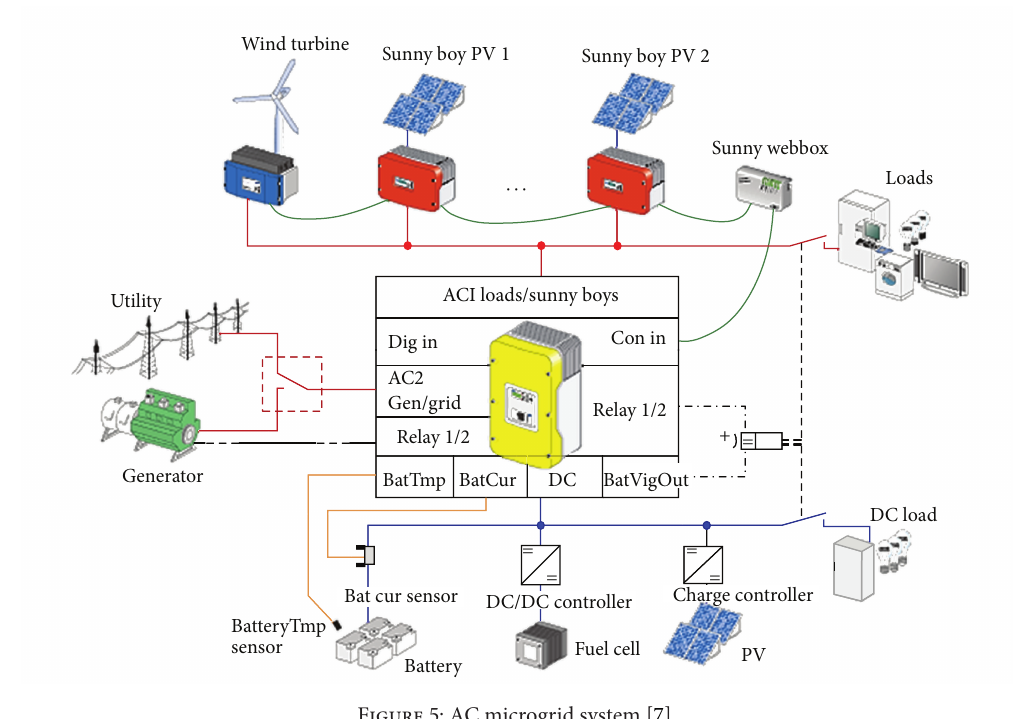
Figure 5: AC microgrid system [7].